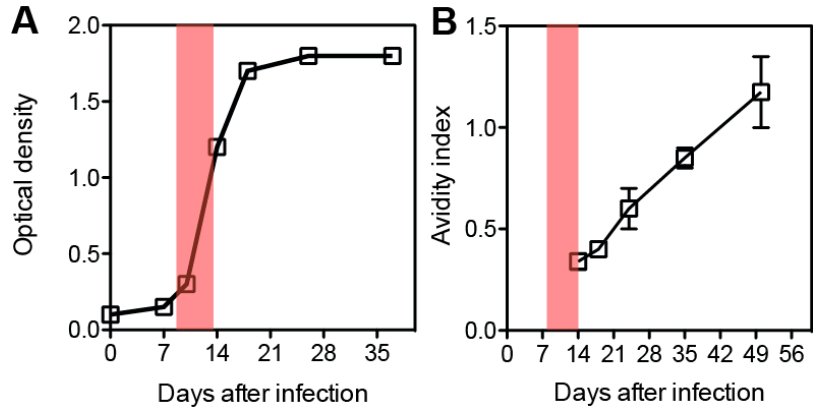
Figure 2. Time course for production of MeV-specific immunoglobulin G (IgG) and maturation of antibody avidity after infection. ( A ) Binding IgG antibody to MeV as determined by enzyme immunoassay; ( B ) Avidity of the antibody from panel A as measured by ammonium thiocyanate elution. Red boxes indicate the period of the rash. Data graphed from Pan et al. [65].